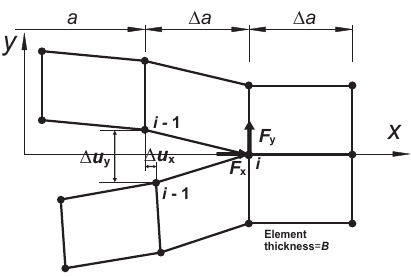
Figure 13. Illustration of the virtual crack closure technique (VCCT) through four nodal elements.